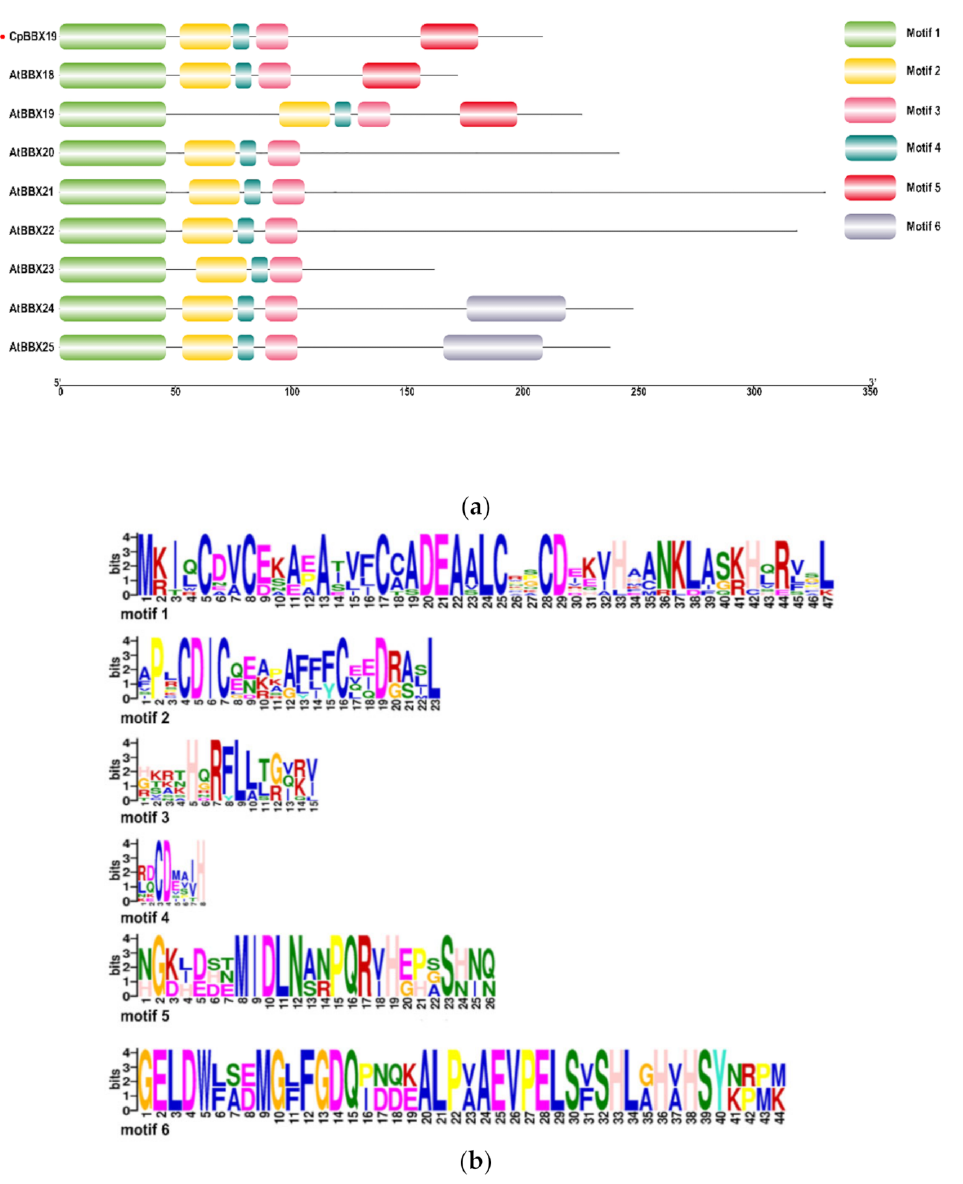
Figure 2. Motif distribution in CpBBX19 and the IV subfamily of the BBX family of Arabidopsis . ( a ) Motif locations. ( b ) The width and amino acid sequence of conservative motifs. CpBBX19 is marked by a red